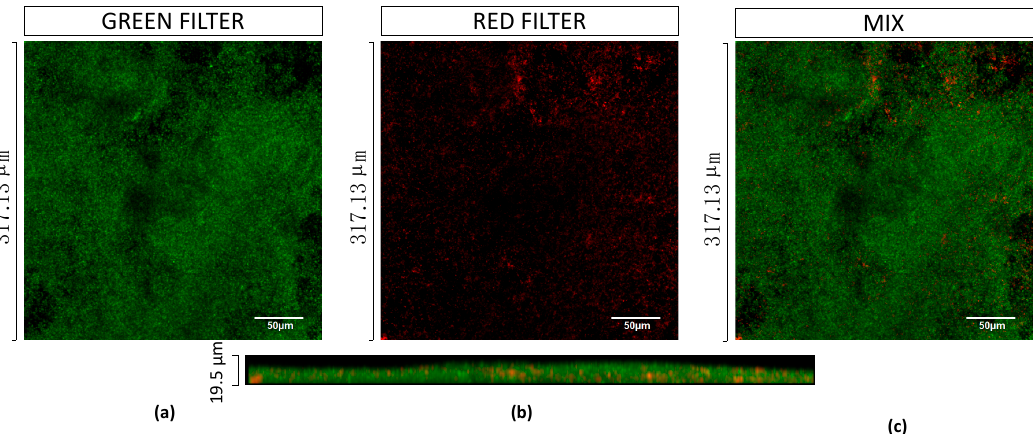
Figure 6. 3D reconstructions of confocal stacks of images of dual-species of P. aeruginosa and S. aureus biofilms. ( a ) 48 h old intact biofilms were stained by using recombinant proteins, LM12_AMI-SH3 (with GFP) specific for S. aureus and ( b )EPA1_TFP (with mCherry) specific for P. aeruginosa . ( c ) 48 h old intact biofilms were stained by using both recombinant proteins. Scale bar represents 50 μ m.